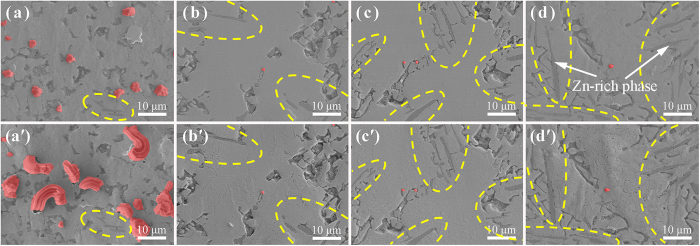
In situ observations of the surface evolutions for four types of Mg/SnCu0.7Znx/Mg sandwich joints after UAS at 250 °C for 6 s followed by thermal aging at 25 °C: (a) and (a’) Mg/SnCu0.7Zn1/Mg aged for 0 and 7 d, respectively; (b) and (b’) Mg/SnCu0.7Zn3/Mg aged for 0 and 7 d, respectively; (c) and (c’) Mg/SnCu0.7Zn5/Mg aged for 0 and 7 d, respectively; (d) and (d’) Mg/SnCu0.7Zn7/Mg aged for 0 and 7 d, respectively. In addition, the clusters of the Zn-rich phase are marked by yellow dotted lines.